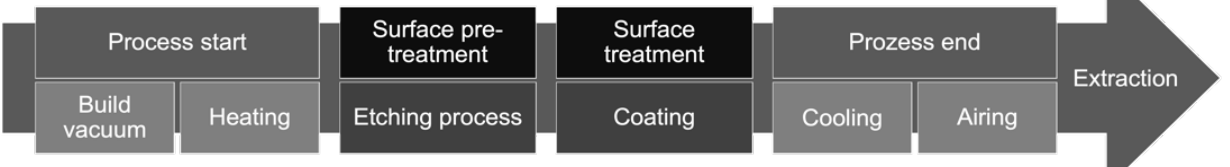
Figure 3. PVD coating process [27,28].